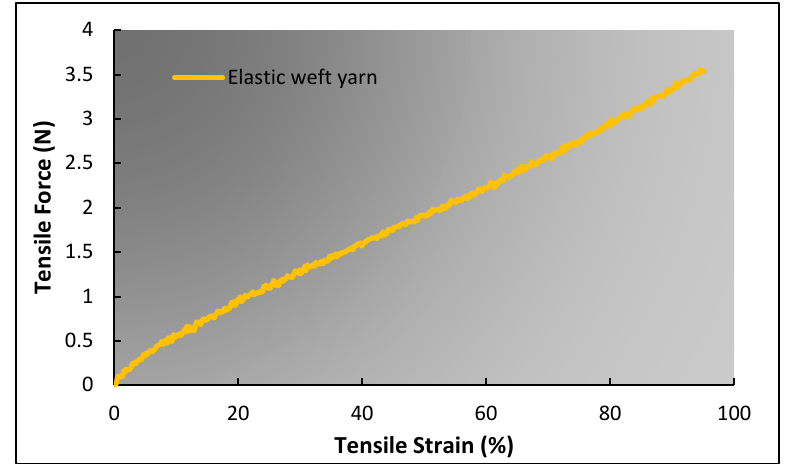
Figure 8. Tensile force–strain curve of elastic weft yarn.